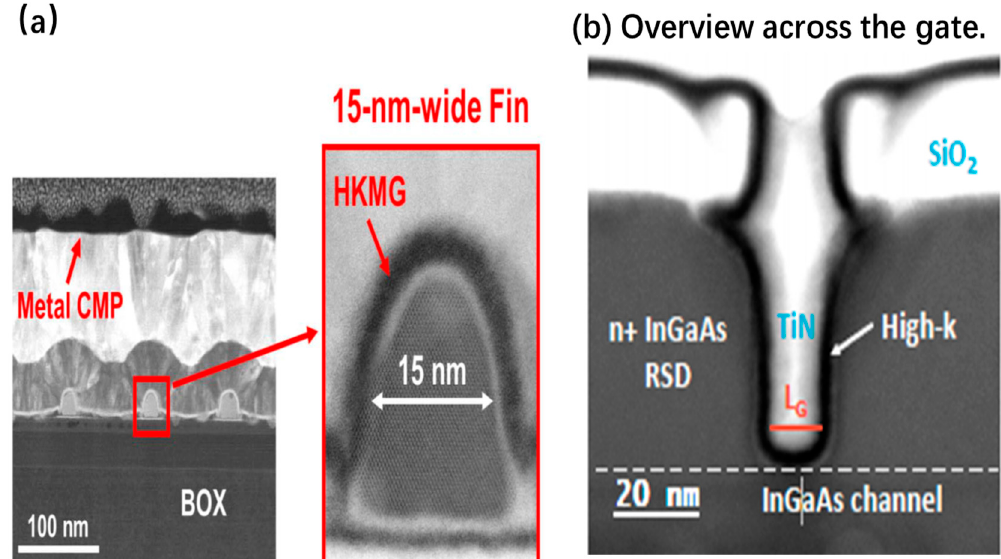
Figure 31. Cross-section images of the self-aligned InGaAs-OI FinFET architecture where ( a ) the scaled HKMG deposited on a 15-nm-wide fin using a highly conformal and uniform PEALD* process [192], and ( b ) shows CS STEM images across the gate showing the InGaAs FinFET with L g = 13 nm [194]. *plasma-enhanced atomic layer deposition.